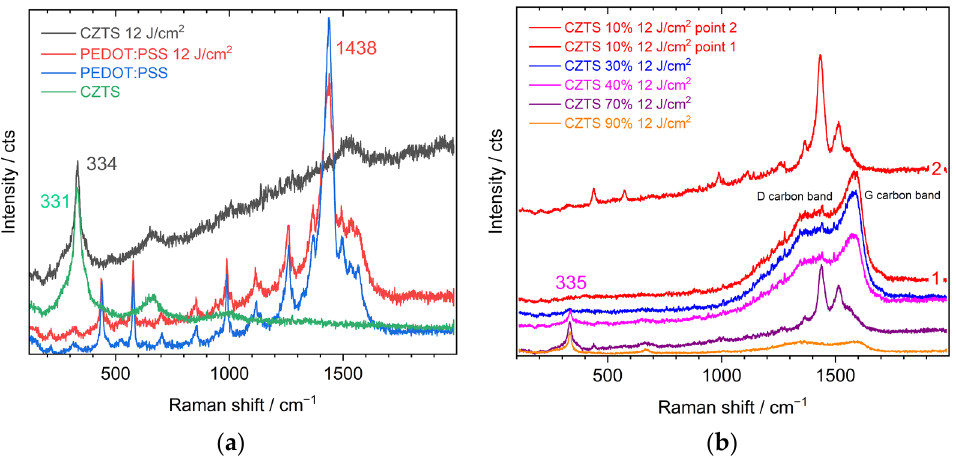
Figure 4. ( a ) Raman spectra for pristine CZTS NC and PEDOT:PSS films and the same films after FLA at 12 J/cm 2 ; and ( b ) Raman spectra for the composite films with different ratios of CZTS NCs and PEDOT:PSS, subject to FLA at 12 J/cm 2 . and PEDOT:PSS, subject to FLA at 12 J/cm 2